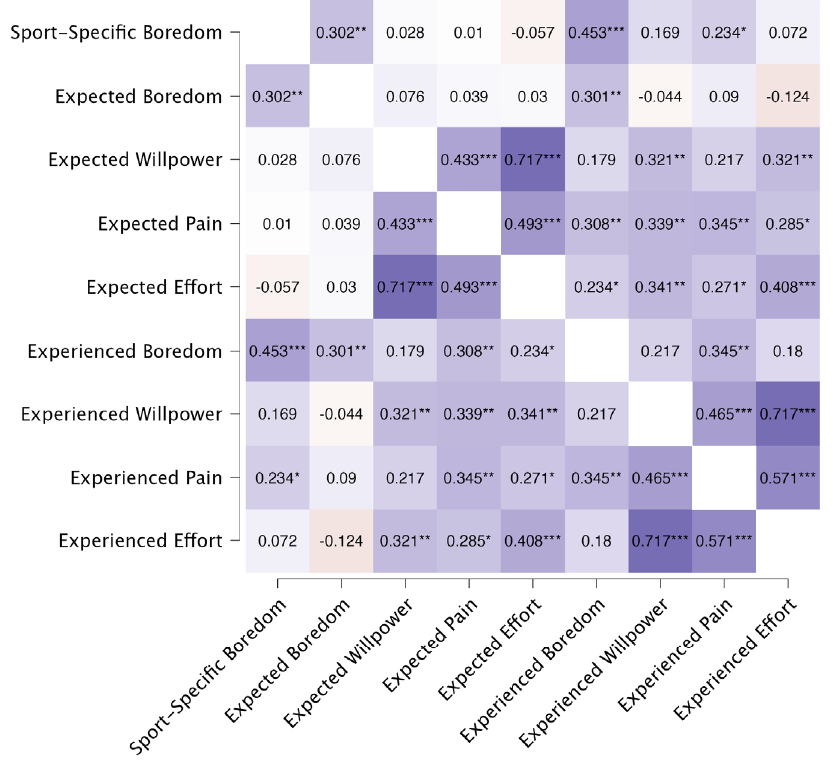
Figure 4. Heatmap reporting correlations (coefficient. r in the according box) between all challenges and the sport-specific boredom score. Significant cases are flagged with asterisks (* p < .05, ** p < .01, *** p < .001).